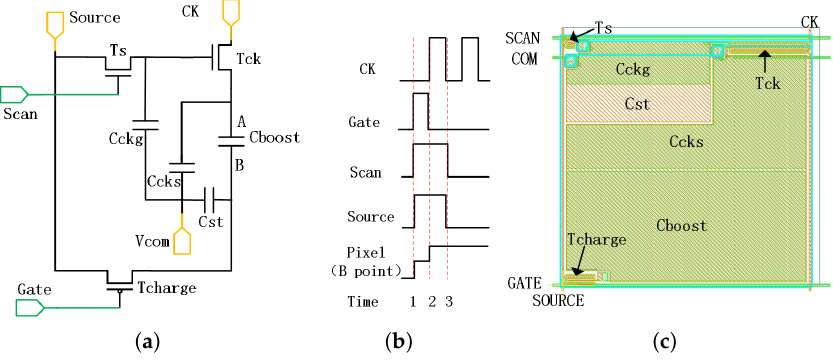
Figure 4. Schematic ( a ), timing ( b ) and layout ( c ) of the pixel with 3T4C boost